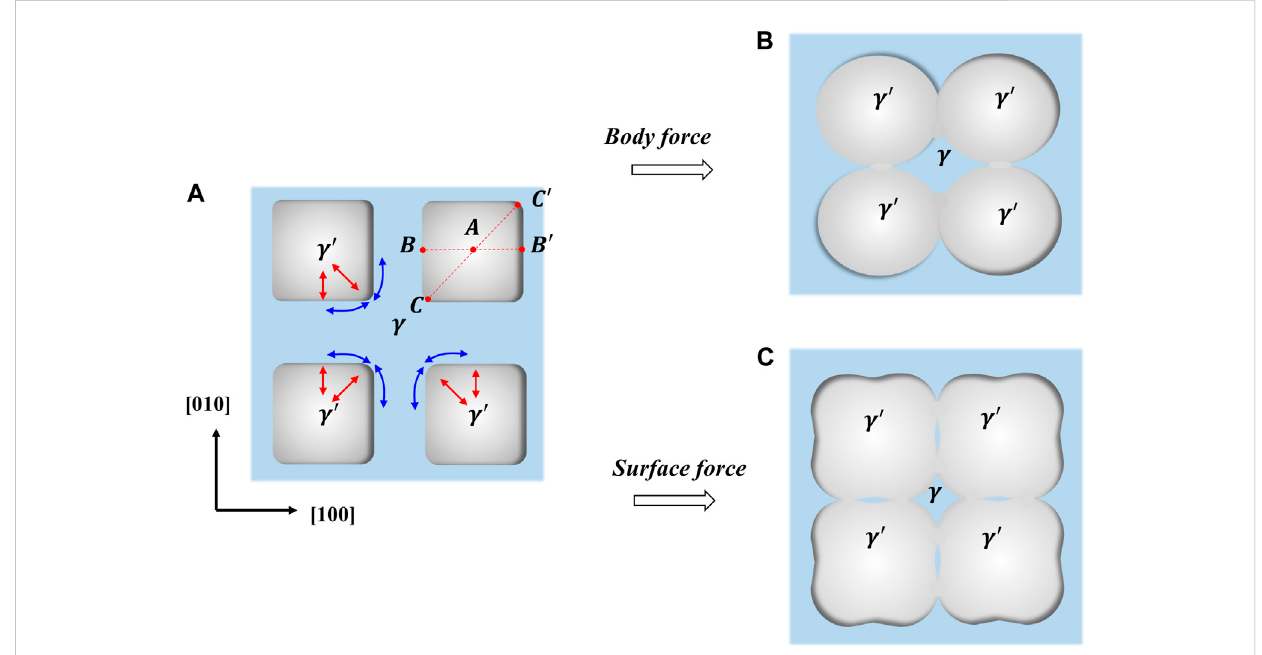
FIGURE 8 (A) Migrationdiagramofthe γ ′ -formersintheprocess of γ ′ raftingunderthebody forceand thesurfaceforceconditions, (B) evolution processof γ ′ precipitates under the body force, and (C) evolution process of γ ′ precipitates under the surface force.